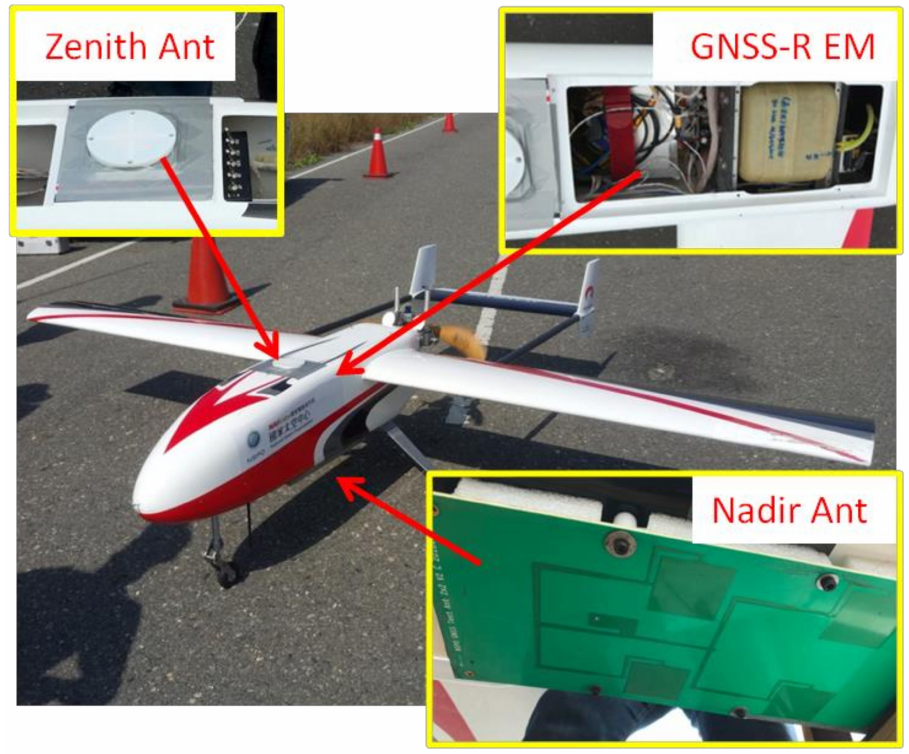
Figure 11. A unmanned aerial vehicle (UAV) flight test with GNSS-R